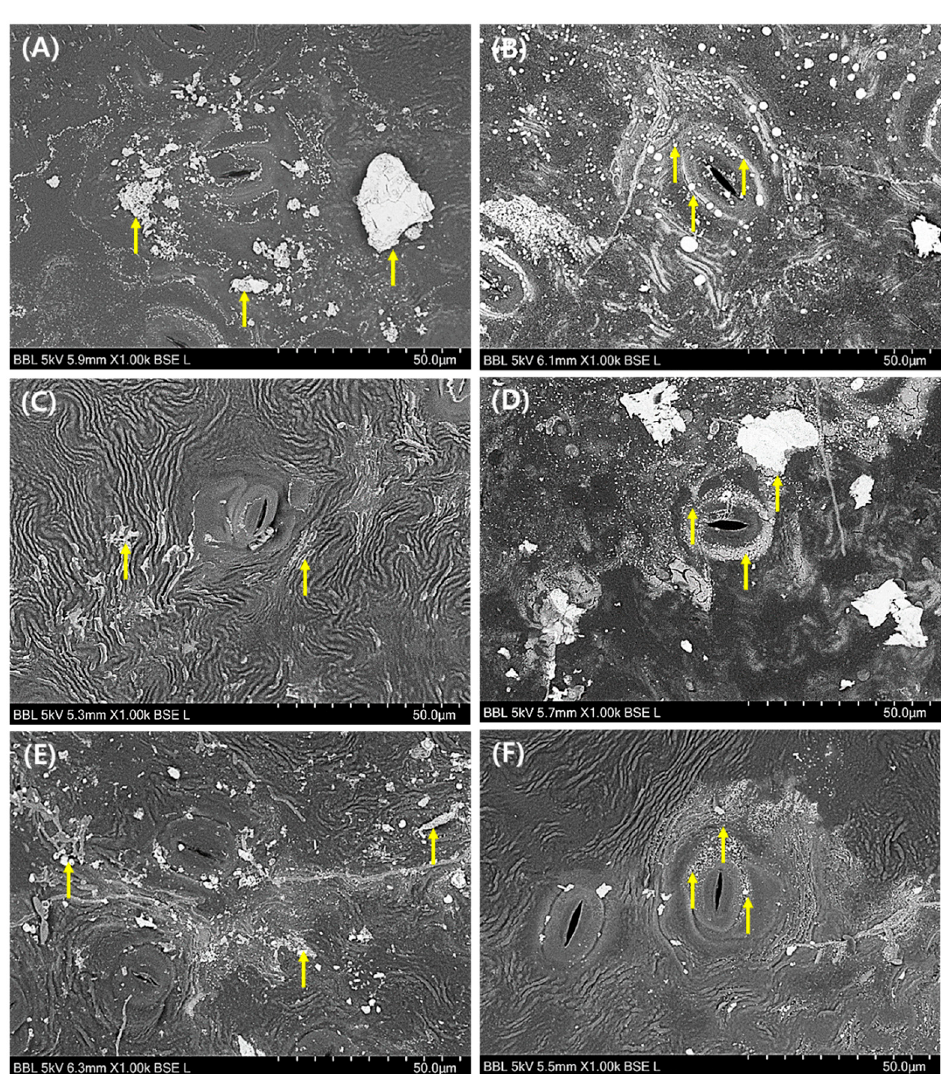
Figure 3. Scanning electron microscopy (SEM) images of abaxial surface of Ardisia japonica leaf under CL (continuous light) with ( A ) drought and ( B ) water supply, under LD cycle (light/dark cycle; 14 h/10 h) with ( C ) drought and ( D ) water supply, and under CD (continuous dark) with ( E ) drought and ( F ) water supply. Symbol ( ↑ ) indicates the distributed particulate matter.